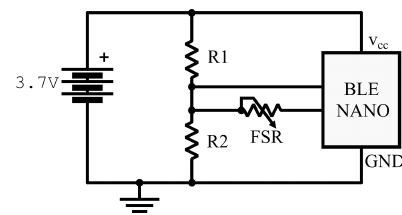
Figure 5. Voltage divider circuit.